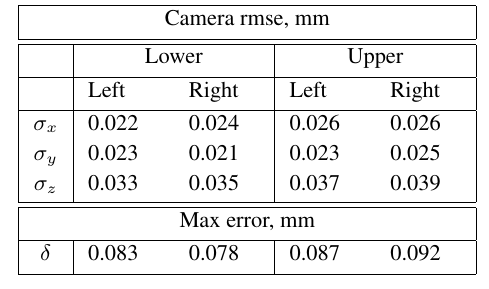
Table 3. Results of system calibration